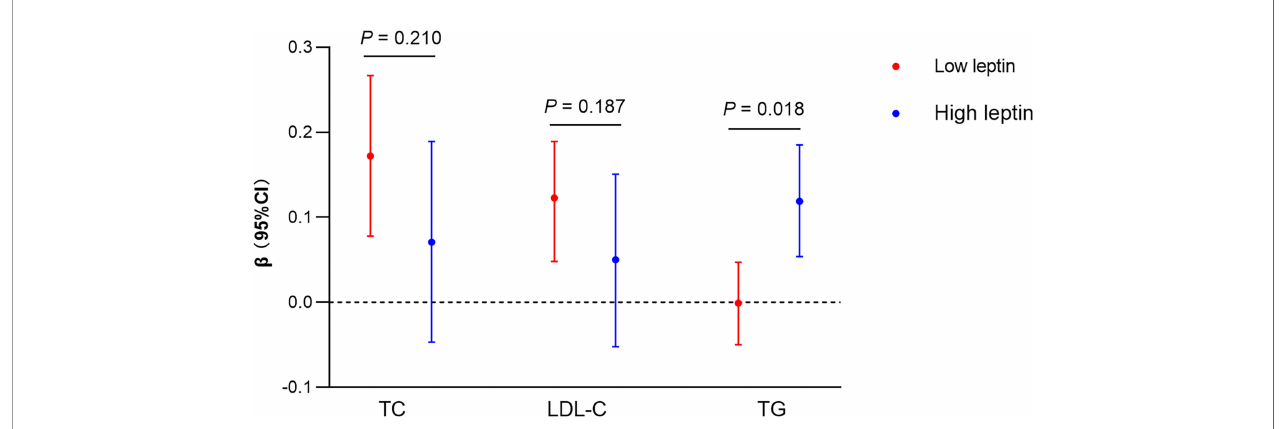
FIGURE 2 | Interaction between ANGPTL8 and leptin on lipids pro fi les. Liner regression analysis of ANGPTL8 on lipids (TG, TC and LDL-C) strati fi ed by high and low (above/below sex-speci fi c median) levels of leptin. Ln-transformed for triglyceride (TG) and ANGPTL8, per z-score increment of each ln-ANGPTL8. Liner regression models and the P for interaction were shown adjusted for age, sex, body mass index, and systolic blood pressure. b , parameter estimate from linear regression; CI, con fi dence interval; TC, total cholesterol; LDL-C, low-density lipoprotein